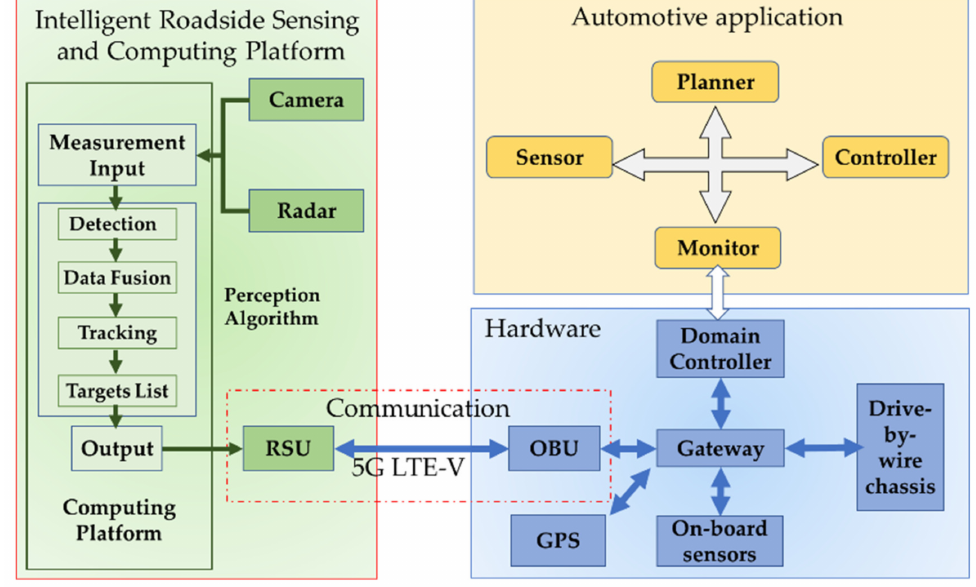
Figure 17. Main components of the system